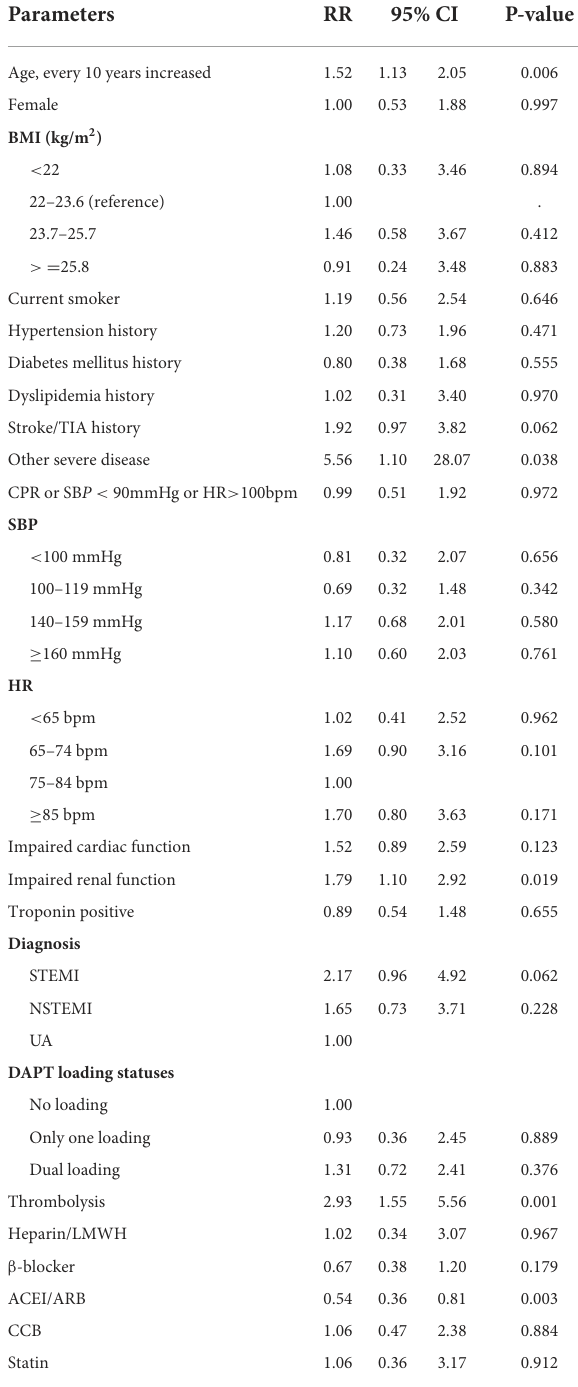
TABLE 2 Risk factors associated with in-hospital major bleeding by multivariable regression